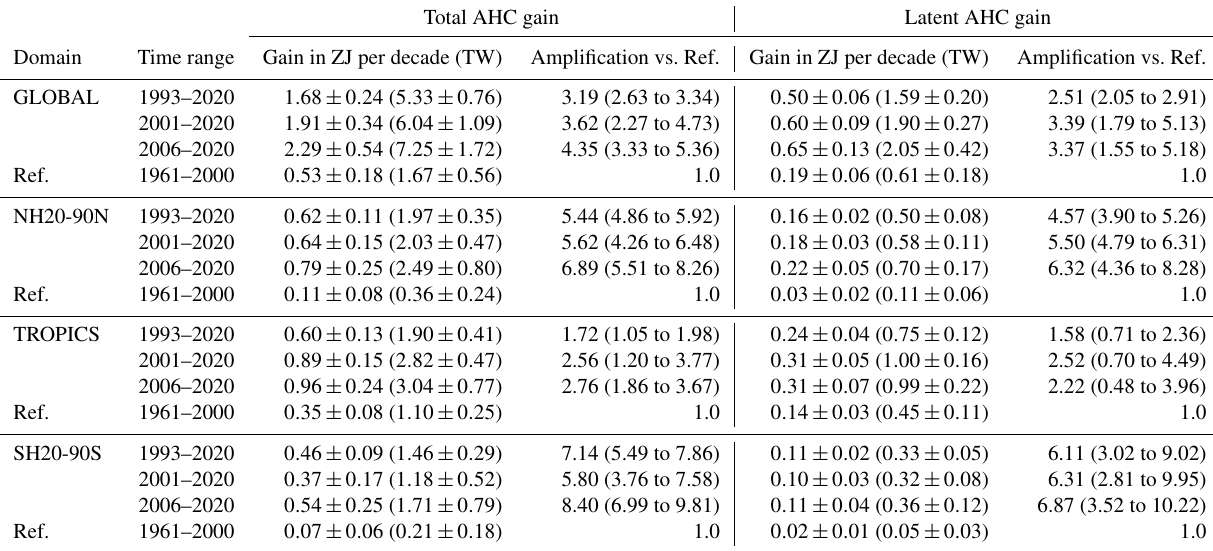
Table 2. Long-term trend values in mean AHC anomalies (AHC gains; in units of zettajoule per decade (ZJ per decade) and terrawatt (TW), the latter listed in parentheses) and amplification factors vs. the 1961–2000 reference gain (lines marked “Ref.”), for total AHC (left block) and latent-only AHC (right block) for the three recent time periods in four geographic domains as illustrated in Fig. 5. The AHC gain and amplification values are listed together with their 90% confidence ranges. Total AHC gain Latent AHC gain Domain Time range Gain in ZJ per decade (TW) Amplification vs. Ref. Gain in ZJ per decade (TW) Amplification vs. Ref.